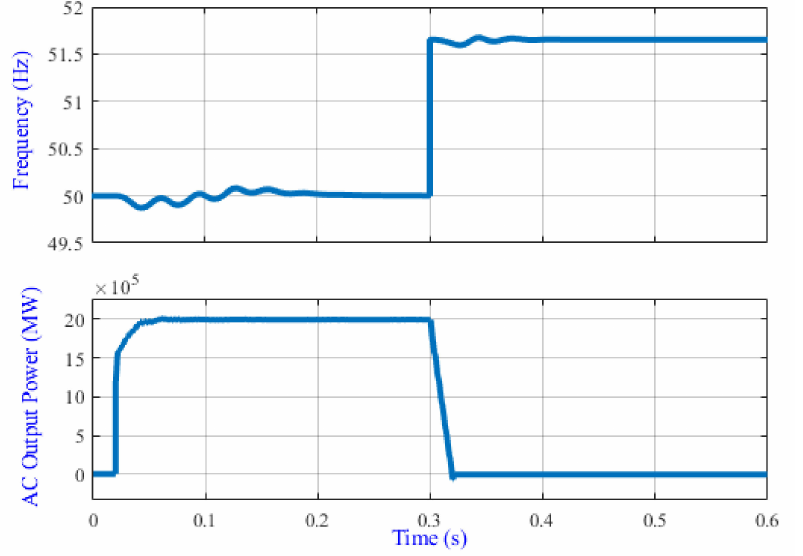
Figure 18. Active power control behavior during normal frequency and the frequency greater than 51.5